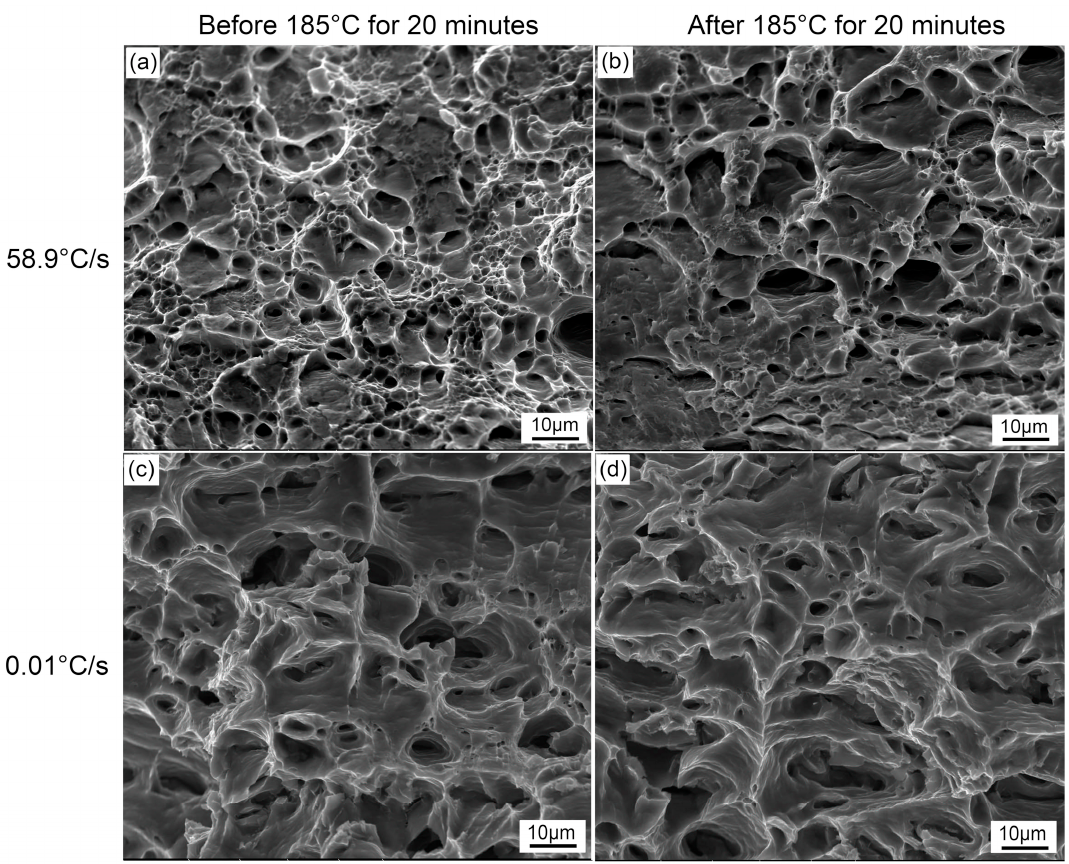
Figure 5. Fracture morphology of samples with different quenching rates before and after paint bake-hardening at 185 °C for 20 min: ( a ) and ( c ), 58.9 °C/s; ( b ) and ( d ), 0.01 °C/s.